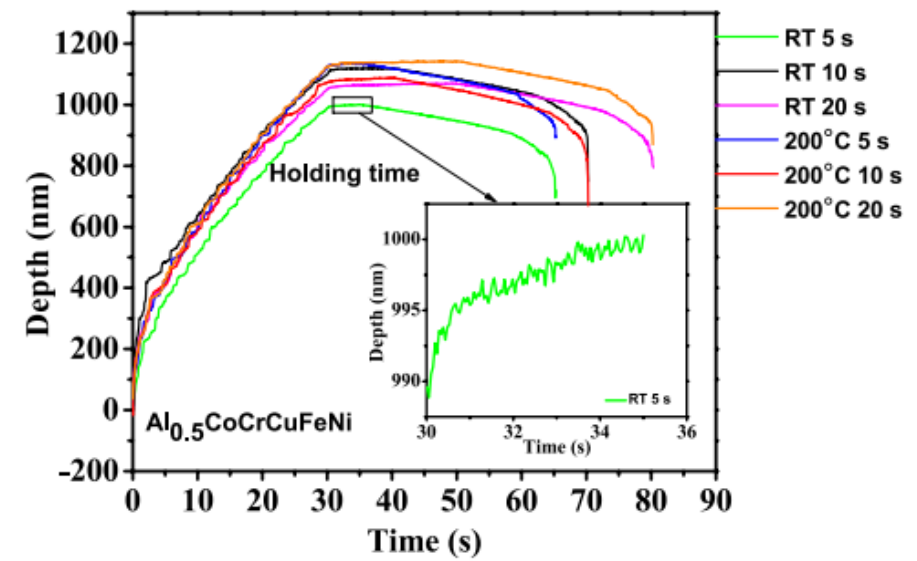
Figure 19. Depth-time curves for the nanoindentation of the Al 0.5 CoCrCuFeNi HEA with the holding times of 5, 10, and 20 s at RT and 200 °C (from Reference [154]).